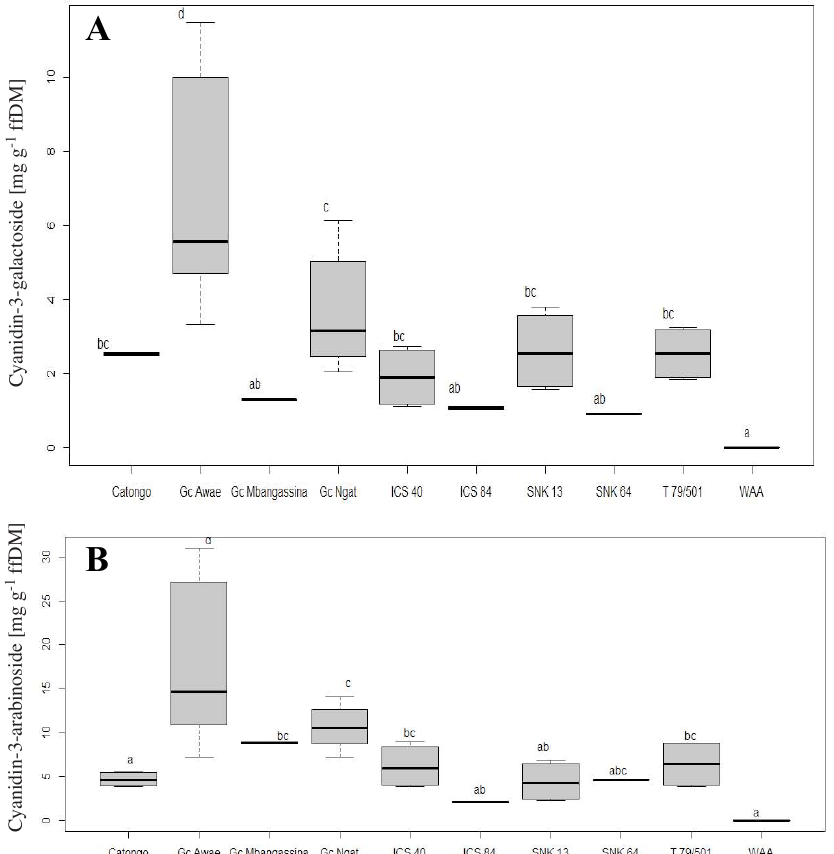
Fig. 3: Cyanidin-3-galactoside (A) and cyanidin-3-arabinoside (B) content from traditional German cacao (Gc) and hybrid varieties. Milled defatted cacao seeds were extracted in methanol and polyphenol analysis was done by HPLC. Mean values (n = 6) with different letters differed significantly at P < 0.05, Post hoc Test: Fisher LSD, P < 0.05. Mean is the result of two analyses from three independents cacao